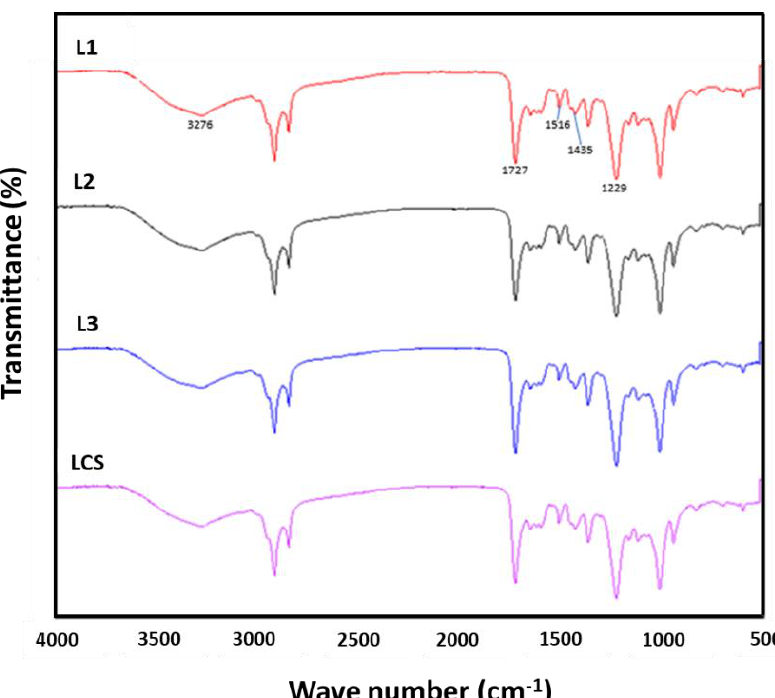
Figure 8. Infrared Fourier Transform (FTIR) of lignin from sorghum Organosolv without (LCS) and with applying high-power ultrasonic pulses. (L1) Lignin treatment time/amplitude—10/20. (L2) Lignin treatment time/amplitude—10/18. (L3) Lignin treatment time/amplitude—10/14.